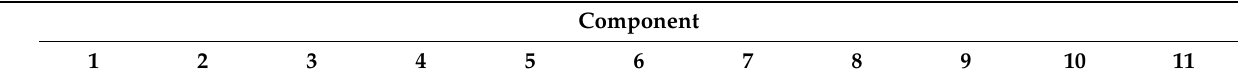
Figure A1. Scree plot of principal component analysis. Table A2. Rotated component matrix (PCA).